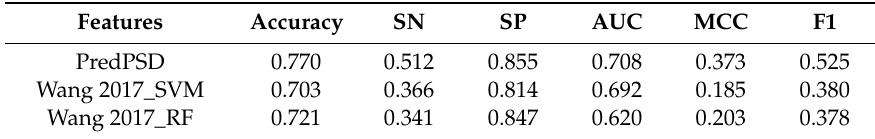
Table 3. Performance of all feature descriptors with GTB algorithms based on the independent dataset and comparisons with existing